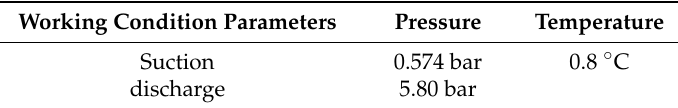
Table 3. The working